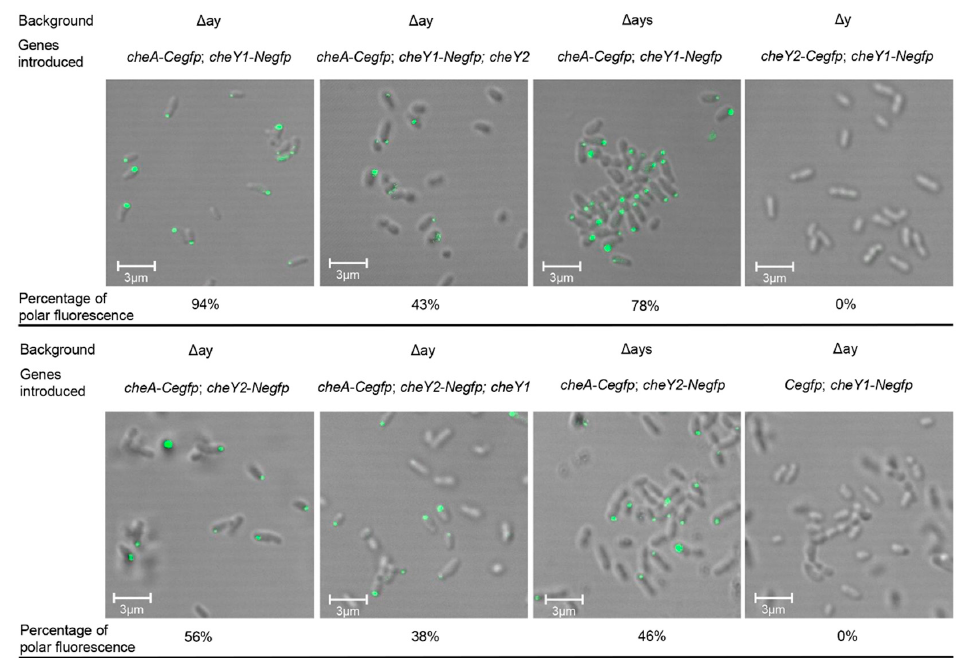
Figure 3. Polar co-localization of CheA with CheY1 or CheY2. eGFP was split into two non-fluorescent parts. The C-terminal part (C egfp ) of eGFP was fused into the C-terminus of CheA (or CheY2) and the N-terminal part (N egfp ) of eGFP was fused to the C-terminus of CheY1 (or CheY2). The introduced genes were equivalently co-expressed in the indicated A. fabrum strains. Interaction between two fusion proteins results in the reconstitution of two split-eGFP parts to emit fluorescence. Cells expressing the indicated fusion genes were observed by using confocal laser-scanning microscopy. The percentage represents the fraction of the cells with polar fluorescence. The background represents the host strains. The introduced genes indicate the genes complemented to the host strain by a plasmid. Δ ay: cheA , cheY1 and cheY2 triple-deletion mutant; Δ ays: cheA , cheS , cheY1 and cheY2 quadra-deletion mutant; Δ y: cheY1 and cheY2 double-deletion mutant.